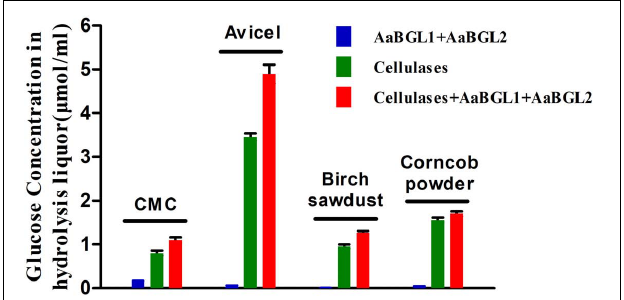
FIGURE 7 | Cooperation of AaBGL1 and AaBGL2 with commercial cellulases in cellulosic material degradation.